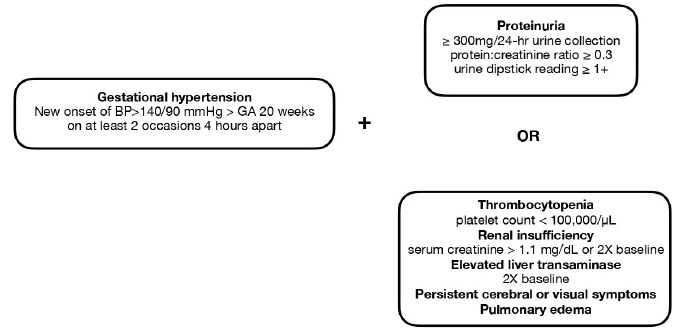
Figure 1. The definitions of gestational hypertension (pregnancy-induced hypertension) and preeclampsia.